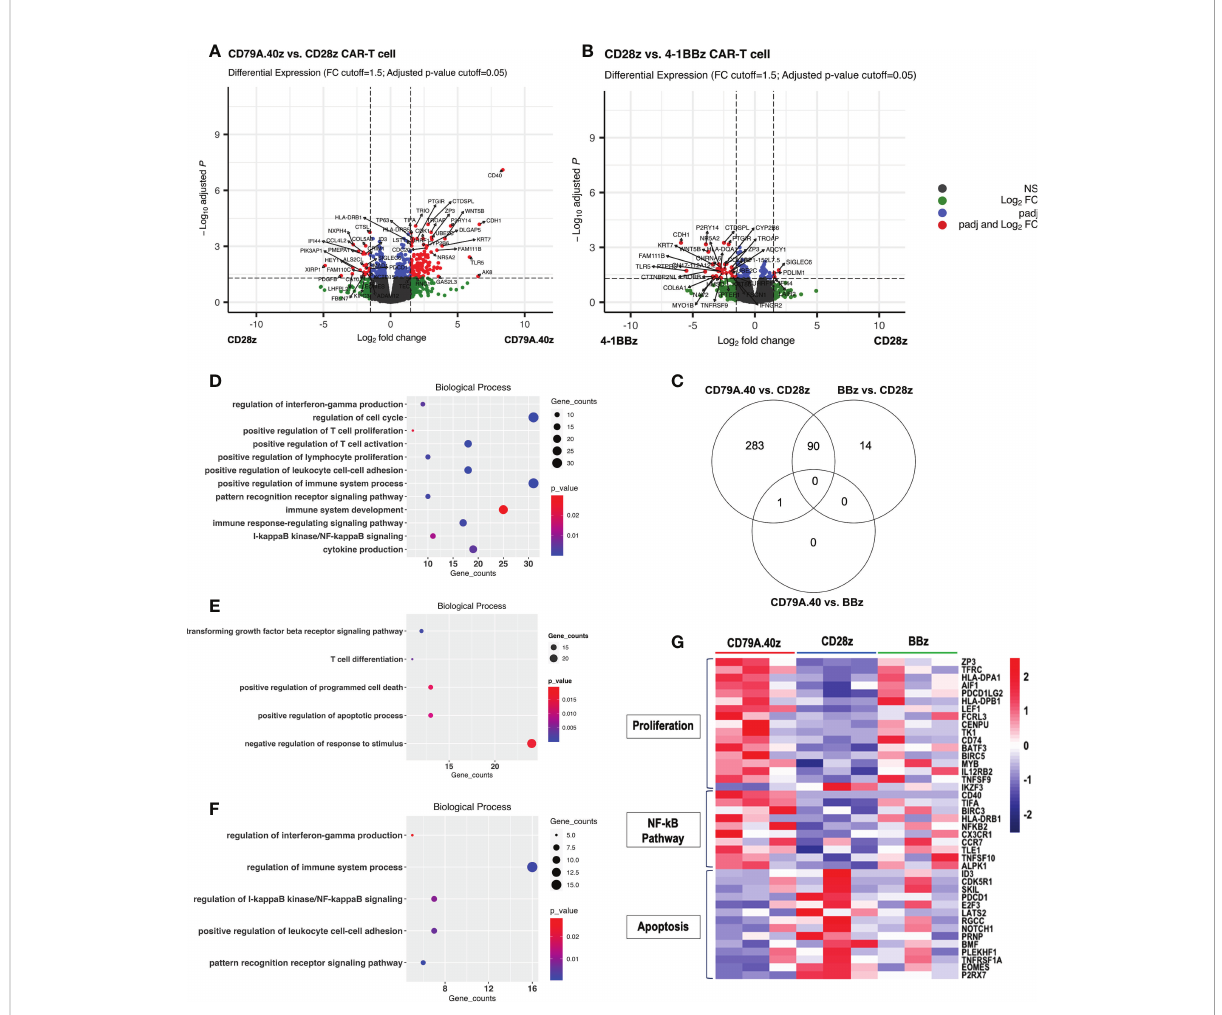
FIGURE 3 Differential gene expression pro fi ling analysis of CD19CAR-T cell. (A, B) Volcano plots of DEGs between (A) CD19.28z CAR-T cells vs. CD19.79A.40z CAR-T cells and (B) , CD19.BBz CAR-T cells vs. CD19.28z CAR-T cells. Visualization of DEGs in volcano plots. Up-regulated- and down-regulated genes with FDR < 0.05 are marked in red. DEGs were selected with thresholds of false discovery rates (FDR) ≤ 0.05 and ≥ 1.5- fold difference. (C) Venn diagram illustrating the number of overlapped DEGs between each comparison: CD19.79A.40z CAR-T cells vs. CD19.28z CAR-T cells, CD19.79A.40z CAR-T cells vs. CD19.BBz CAR-T cells, and CD19.BBz CAR-T cells vs. CD19.28z CAR-T cells. (D – F) Gene ontology-biological processes (GO-BP) of up- (D) and down-regulated DEGs (E) in CD19.79A.40z CAR-T cell compared to CD19.28z CAR-T cells. (F) The up-regulated DEGs in CD19.BBz CAR-T cells compared to CD19.28z CAR-T cells. (G) . Heatmap of normalized counts, under the indicated CD19CAR-T cells in three major categories related to proliferation genes, NF- k B pathway genes, and apoptosis genes. Gene names are listed on the right side and each CAR structure is marked at the top of the colored map. The color bar indicates the normalized counts